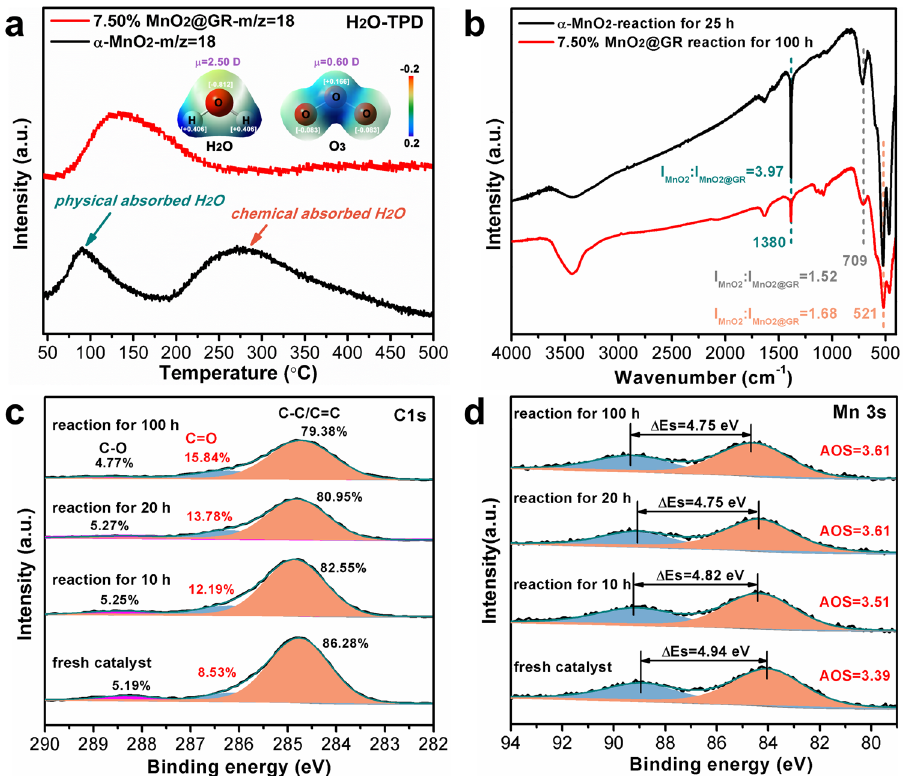
Fig. 5 The unique advantages of MnO 2 @GR in ozone conversion. a TPD-MS pro fi les of MnO 2 and 7.50% MnO 2 @GR. Insets: surface electrostatic potential and molecular dipole of O 3 and H 2 O. b FTIR spectra of α -MnO 2 and 7.50% MnO 2 @GR treated with O 3 . Mn 3s ( c ) and C 1s ( d ) spectra of 7.50% MnO 2 @GR treated with ozone for a different